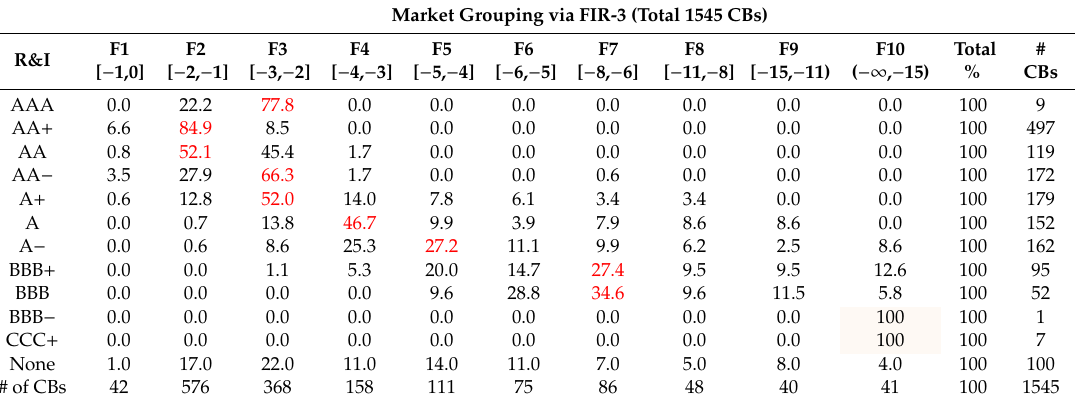
Table 6. Cross-table of R&I rating groups and Crisk rating classes, where the number in each cell is the percentage ratio relative to the total number of CBs in the rightmost column. The highest percentage ratio in each row is highlighted.